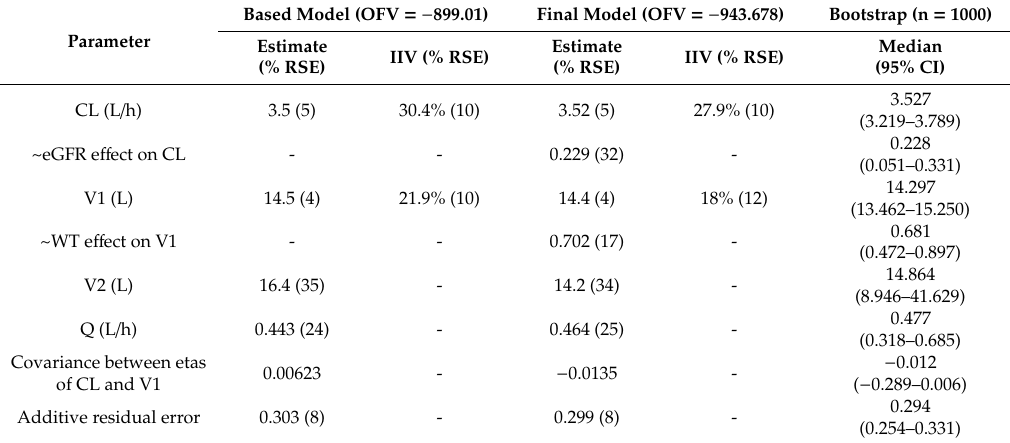
Figure 2. Prediction-corrected visual predictive check for the final population pharmacokinetic model. The solid circles represent the observed amikacin serum concentrations; the solid lines represent the 5th (blue), median (red), and 95th (blue) percentiles of the observed concentration; the dashed lines represent the 5th (blue), median (red), and 95th (blue) percentiles of the simulated concentration; the blue and red areas indicate the 90% confidence interval of the simulated concentrations of each percentile. Table 2. Pharmacokinetic and covariate parameters in the base and final population